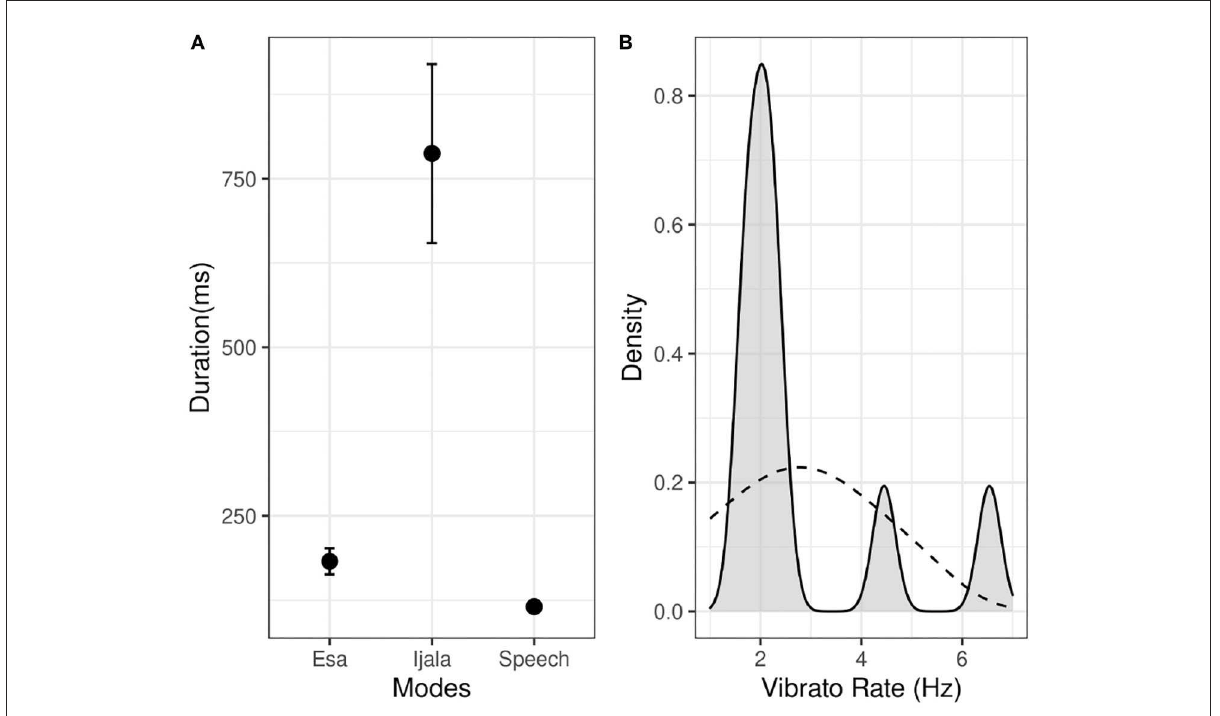
FIGURE2 (A) Vibrato [a] in Ìjálá and the corresponding non-vibrato [a] in speech and È.sà modes; (B) Vibrato rate(Hz) of the relevant vowels in Ìjálá